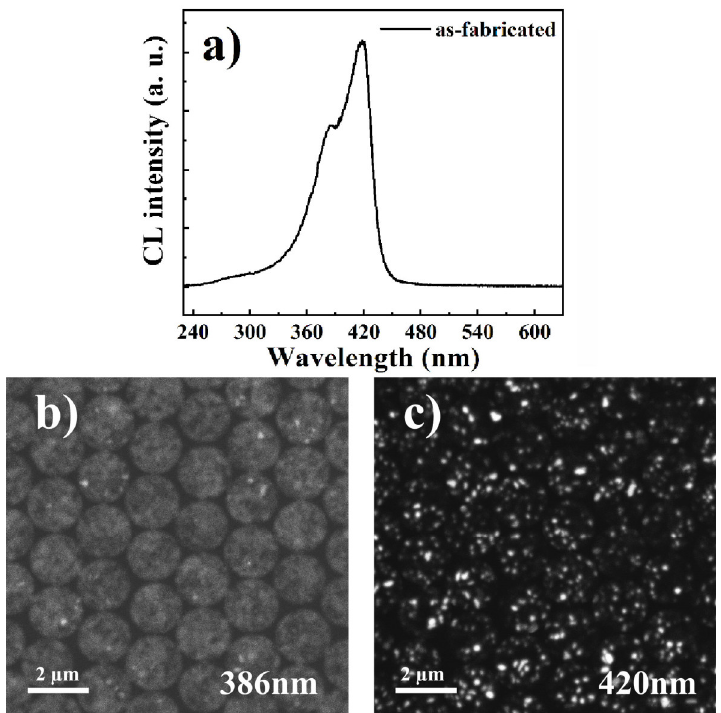
Figure 7. CL spectrum of N-polar nanopillar MQW illustrating two peaks at 386 and 420 nm, respectively ( a ). Monochromatic CL intensity distribution of N-polar nanopillar MQW at 386 nm ( b ) and 420 nm ( c ), respectively.